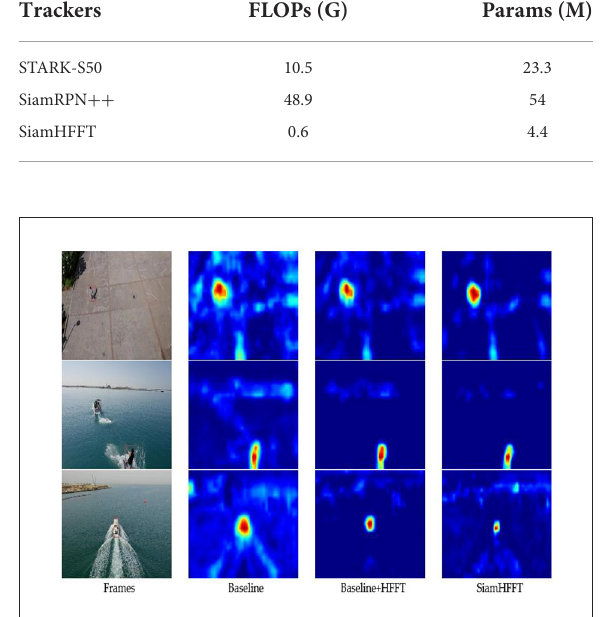
FIGURE8 Visualization of the confidence maps of three trackers on several sequences from the UAV123 dataset. The response visualization results are an intuitive reflection of tracker performance.